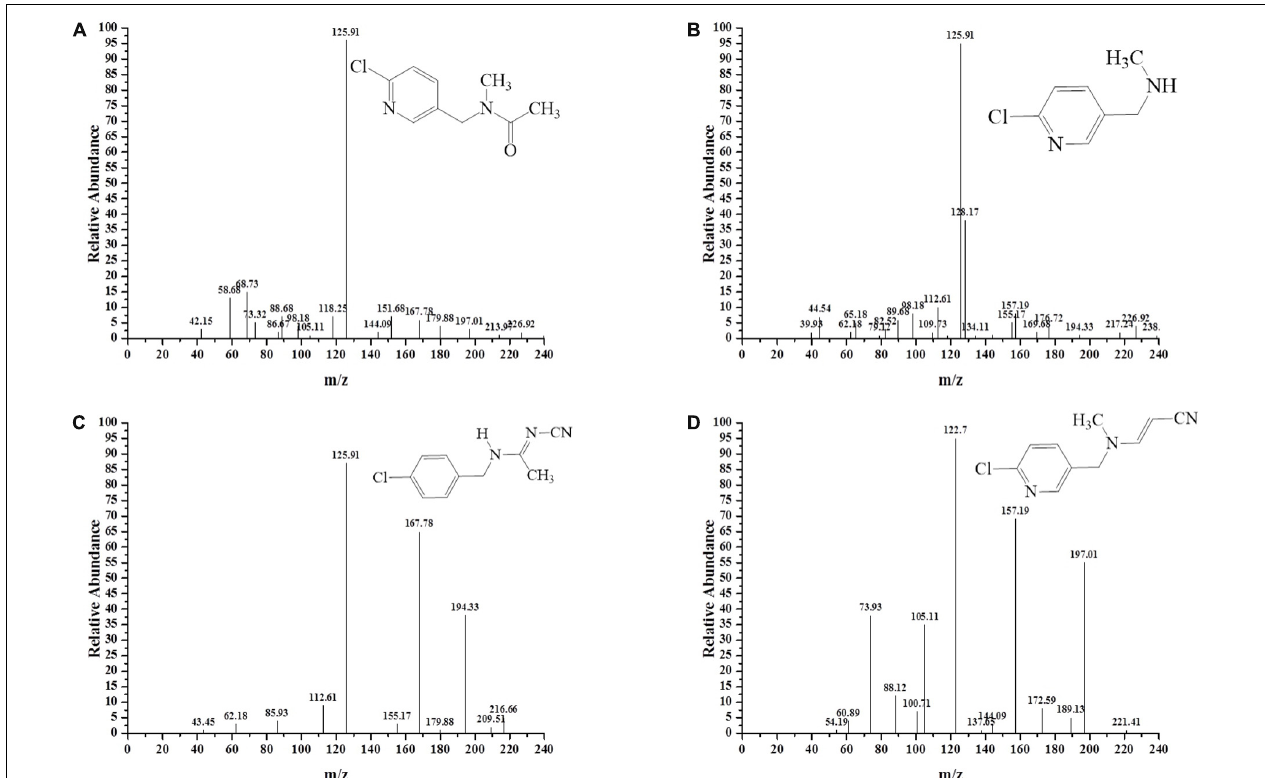
FIGURE 3 | MS/MS identification of the metabolites produced during acetamiprid degradation. Second-order mass spectra of (A) compound I; (B) compound II; (C) compound III; (D) compound IV.